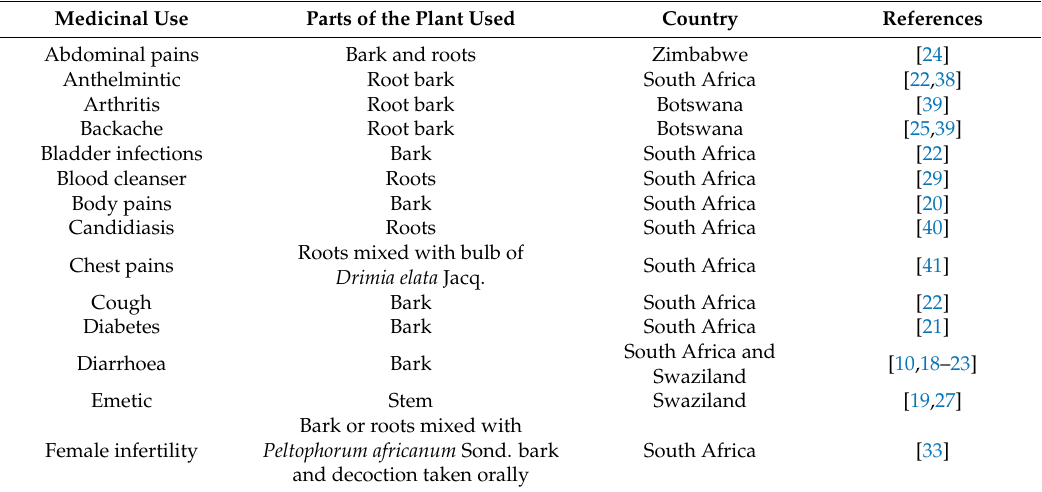
Table 1. Medicinal uses of Elaeodendron